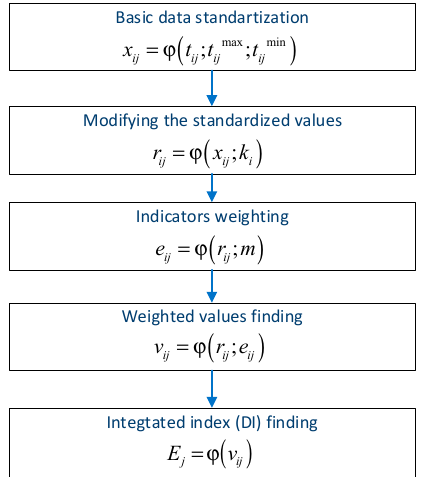
Figure 3. The algorithm DI finding. Source: Own Work.